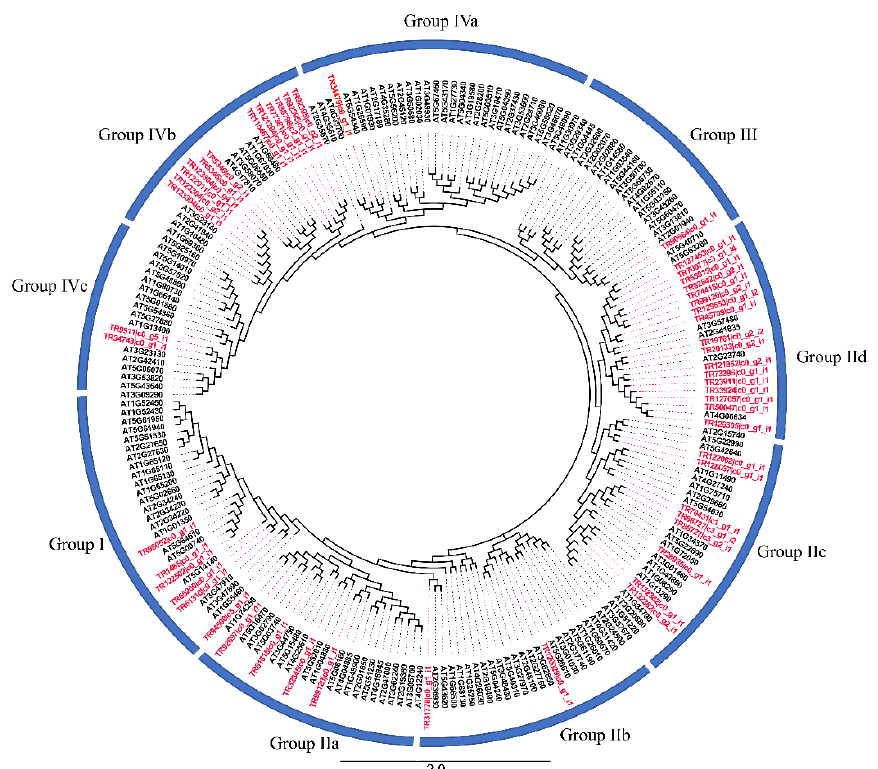
Figure 1. Phylogenetic analysis of the BaZFP proteins among B. argenteum (red) and A. thaliana (black). The phylogenetic tree was constructed using the maximum likelihood (ML) tree method.